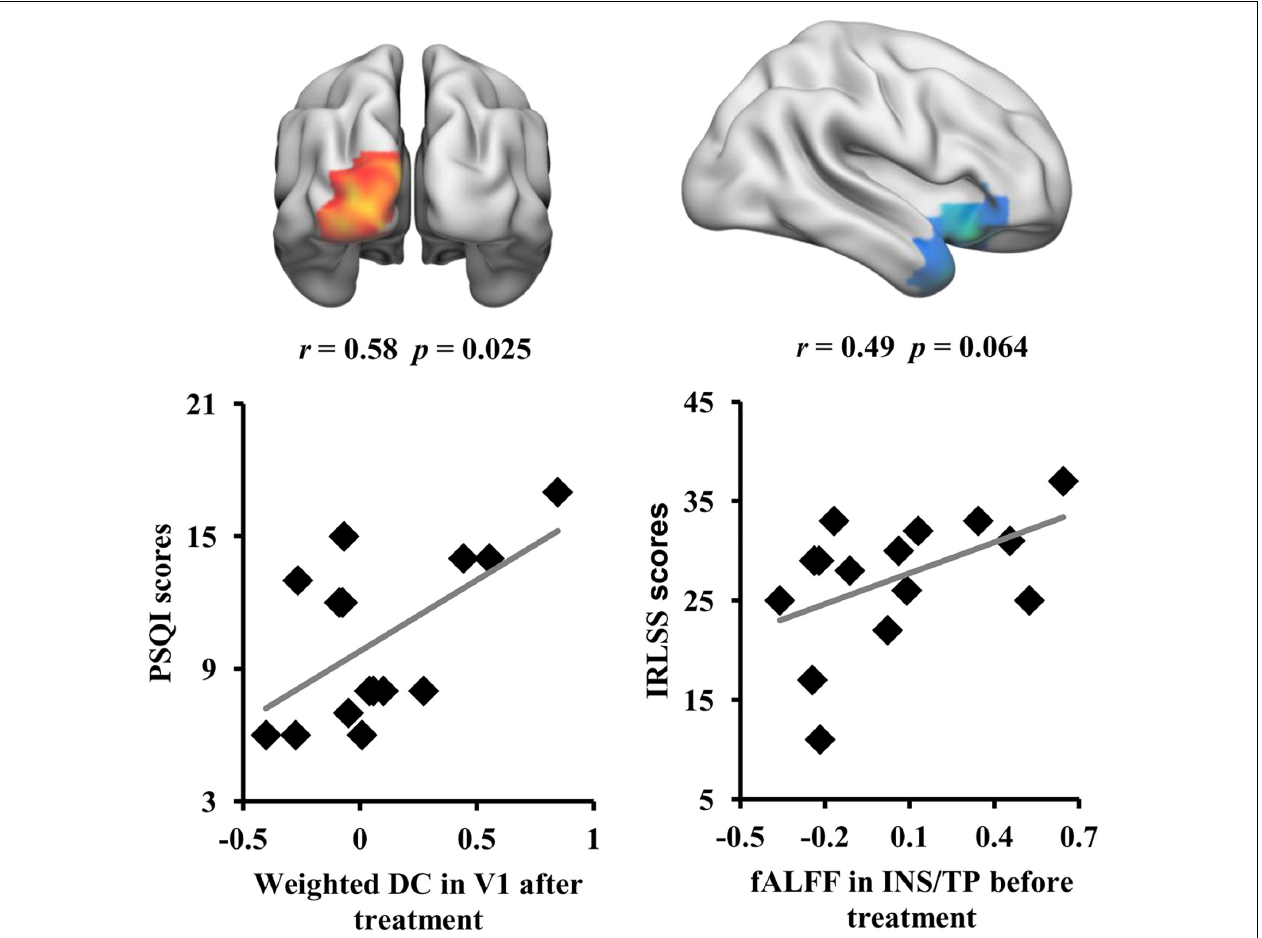
FIGURE 4 | Correlation analyses between neuroimaging indices and clinical characteristics. A significant correlation was found between the weighted DC values of V1 in restless leg symptom (RLS) patients after transcutaneous spinal cord direct current stimulation (tsDCS) treatment and Pittsburgh Sleep Quality Index scores. A marginal correlation between the fractional amplitude of low-frequency fluctuation values of the right anterior insula/temporal pole in RLS patients before tsDCS treatment and the international RLS Rating Scale scores was